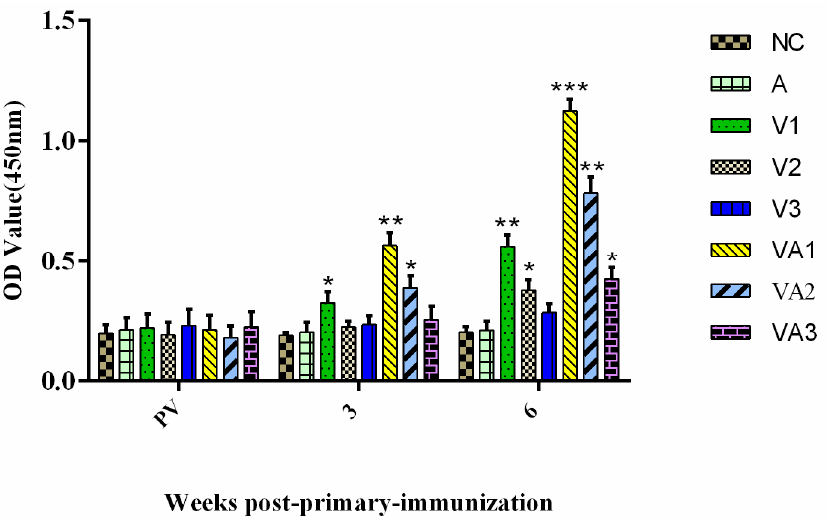
Figure 1. Detection of serum antibody levels induced by inactivated virus vaccine in tilapia: five blood samples of each group from the vaccinated fish were collected pre-vaccination (PV) and at three and six weeks post primary immunization (WPPI). The antibody response was determined by an indirect ELISA, and the tires were indicated at OD 450 . Data are presented as the means ± SD. A comparison between the vaccinated groups with the NC (negative control group injected with sterile PBS) or A (the adjuvant control group injected with sterile PBS mixed with the adjuvant) groups is shown. Differences in the antibody levels between vaccinated and control fish were analyzed by the Student’s t -test. The different numbers of asterisks indicate significant differences in antibody levels at p < 0.05. NC, PBS control; A, PBS and adjuvant; V1, vaccine at 1 × 10 8 TCID 50/mL ; V2, vaccine at 1 × 10 7 TCID 50/mL ; V3, vaccine at 1 × 10 6 TCID 50/mL ; VA1, vaccine at 1 × 10 8 TCID 50/mL and adjuvant; VA2, vaccine at 1 × 10 6 TCID 50/mL and adjuvant; and VA3, vaccine at 1 × 10 6 TCID 50/mL and adjuvant (see text for details).* p < 0.05, ** p < 0.01 and *** p < 0.001.